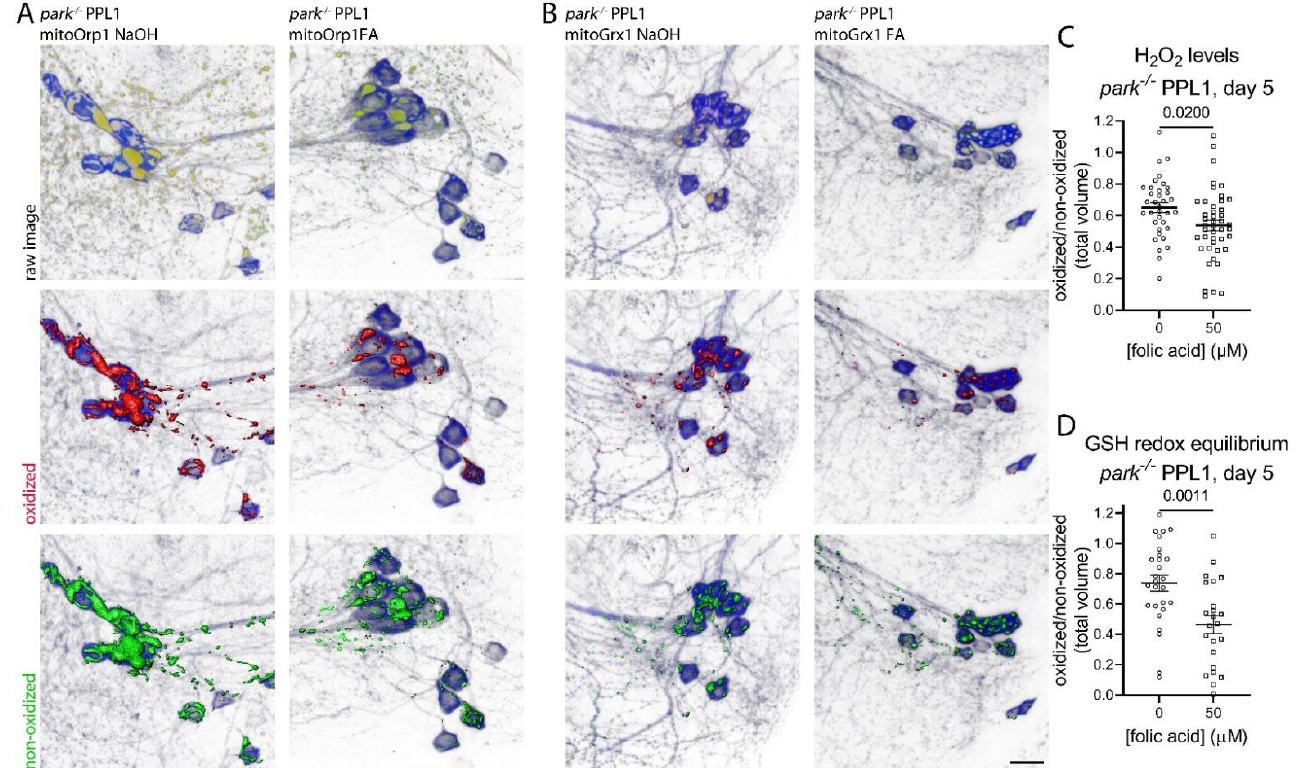
Figure 5. Folic acid administration decreases PPL1 mitochondrial hydrogen peroxide levels and glutathione redox equilibrium in parkin-null flies on day 5. Brains were dissected from folic acid- treated park −/− flies expressing ( A ) mito-roGFP2-Orp1 or ( B ) mito-roGFP2-Grx1 on day 5 post- eclosion, and ( C , D ) ratios of total volumes of oxidized to non-oxidized fluorophore emissions were calculated for one PPL1 region per brain. ( A ) Representative raw images are shown in the top row, where blue indicates tyrosine hydroxylase antibody labeling, and red and green indicate oxidized and non- oxidized roGFP2, respectively. Selected volume “isosurfaces” of oxidized (red, middle row) and non-oxidized (green, bottom row) ( A ) mito-roGFP2-Orp1 and ( B ) mito-roGFP2-Grx1 above threshold are also shown. Scale bar, 10 µm. ( C , D ) Unpaired t tests were run to determine the effect of folic acid administration on hydrogen peroxide levels and glutathione redox equilibrium. Each data point represents the ratio from one PPL1 region ( n ≥ 23). Error b ars represent standard error of the mean, and p values are reported for each comparison.